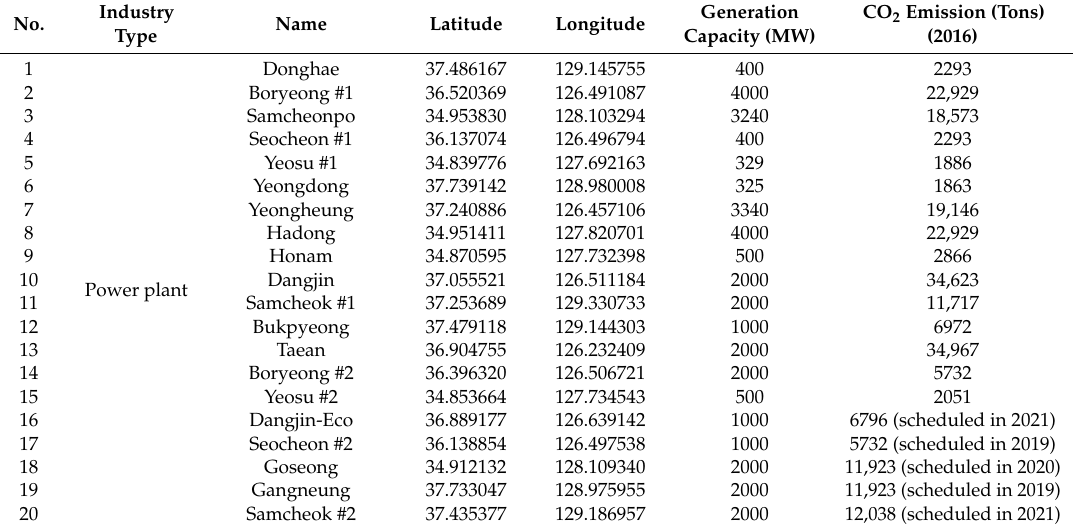
Table 1. Candidate power plants and industrial facilities in the CCS